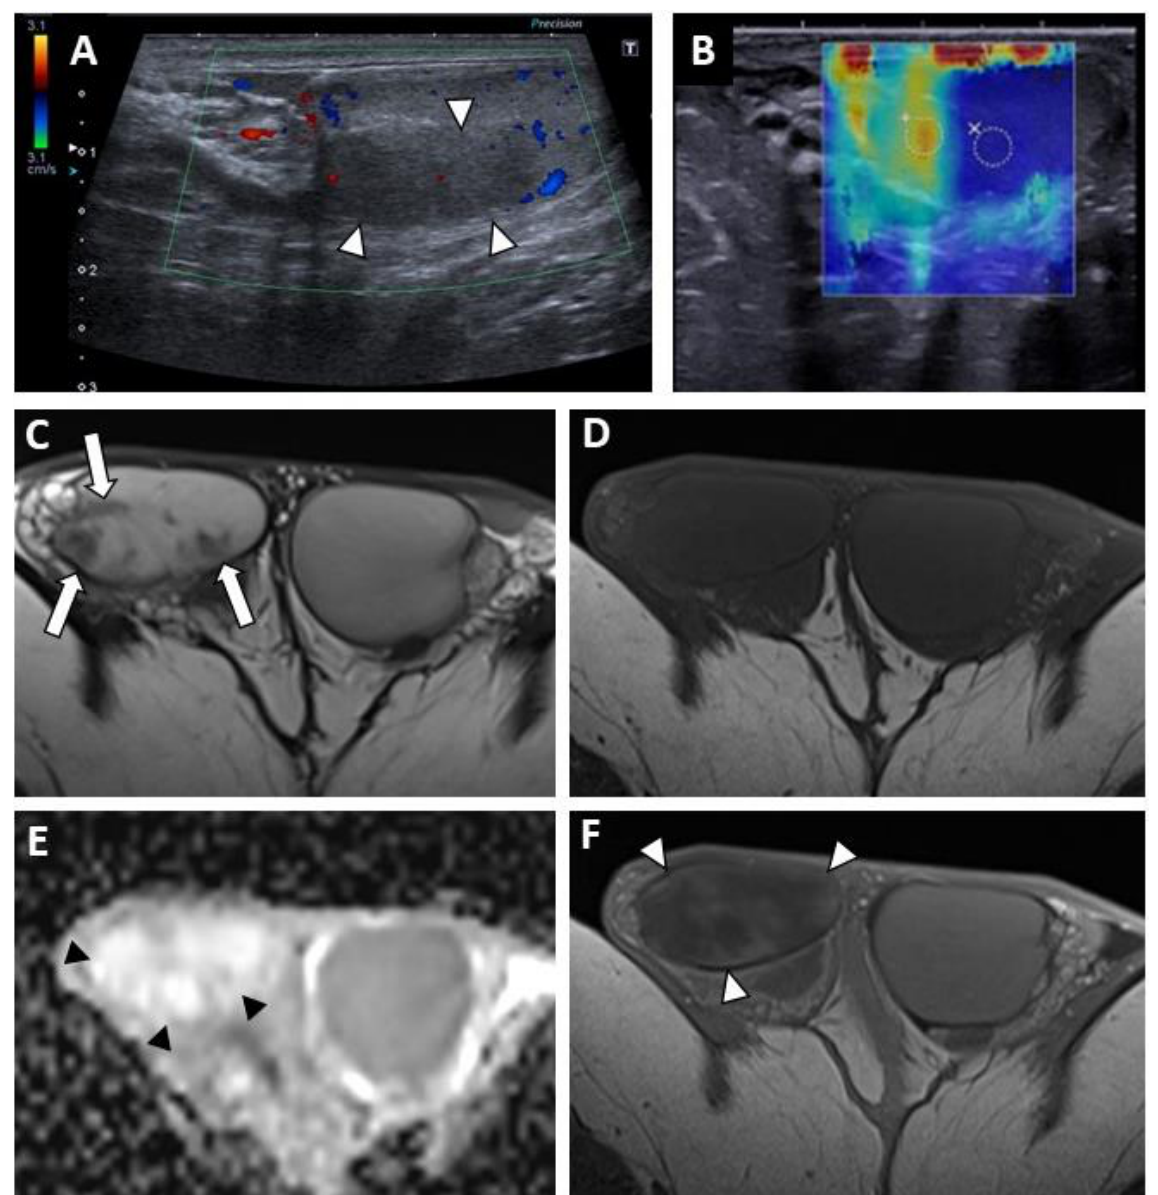
Figure 2. BOTT of the right testis in a 40-year-old man (symptomatic retroperitoneal nodes). Longitudinal image of US on Colour Doppler mode showing poorly circumscribed hypoechoic and hypovascularised nodular areas (white arrowheads) ( A ). Shear-wave elastography mapping showed a focal induration ( B ) (different slice plane from image ( A )). Axial T2W image showed multiple irregular areas with a hypo-intense signal (white arrows) ( C ). Axial T1W image without a detectable focal lesion ( D ). ADC map of the diffusion sequence demonstrated a focal area with an elevated ADC value compared with the contralateral testis (black arrowheads) ( E ). After the intravenous injection of gadolinium chelate, confluent areas with reduced enhancement were visible (note that these areas are overlapping the nodules visualized in T2) ( F